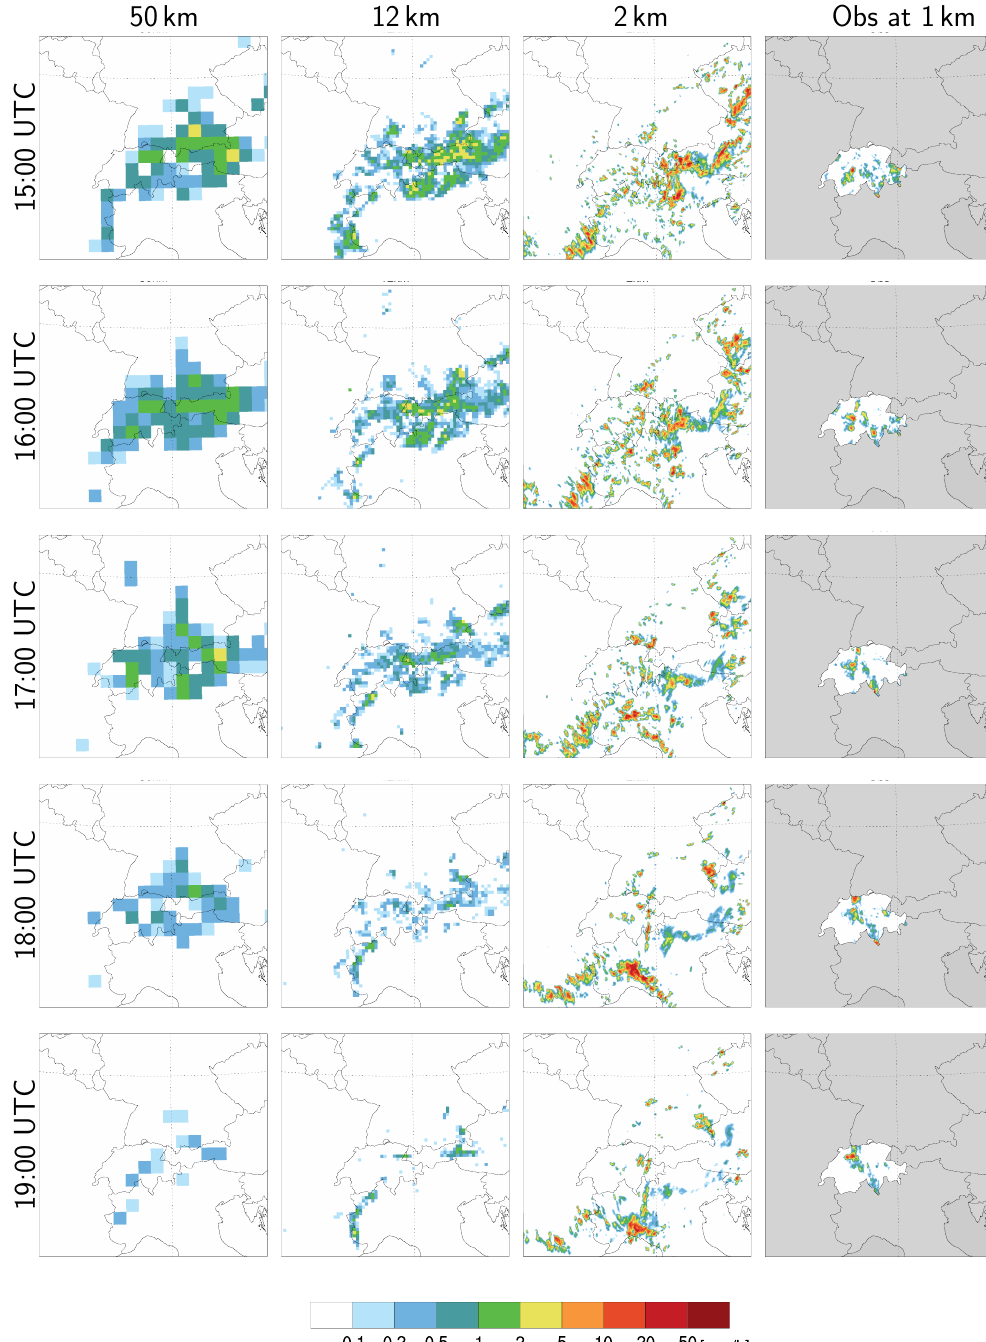
Figure 8. Hourly precipitation amount for a deep moist convection event on 12 July 2006 during 15:00–19:00UTC (from top to the bottom) over the greater Alpine region obtained from a regional climate model at (first column) 50 km and (second column) 12km with convection parameterization scheme on, (third column) at 2km with convection parameterization switched off, and (fourth column) gridded hourly precipitation observations [139]. The model results present snapshots from decade-long simulations presented by Ban et al.